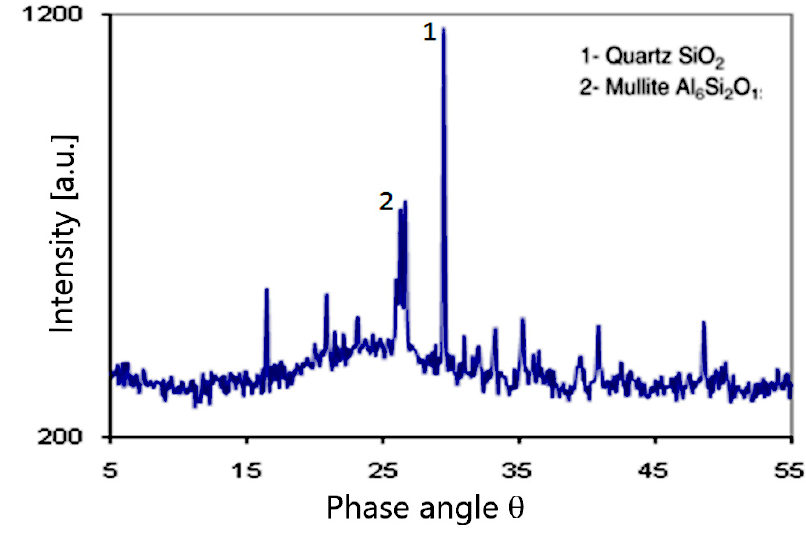
Figure 3. Mineralogical composition of bottom ash (BA) using X-ray diffraction.